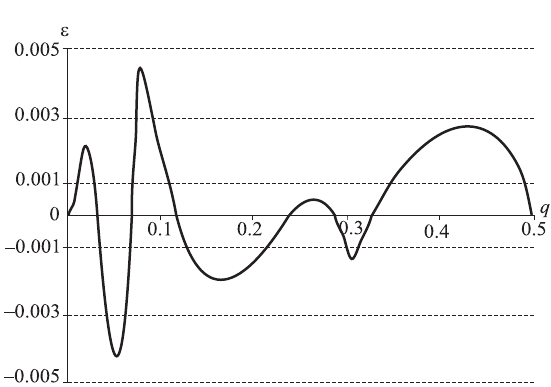
Fig. 5. Distribution of the difference ε (errors) of the exact and approximate solution (18–20) of the